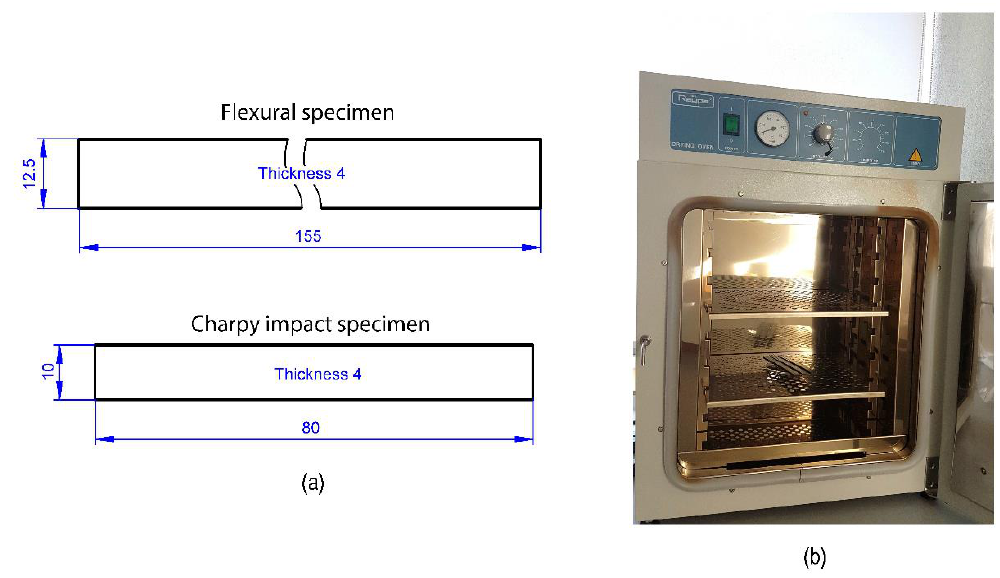
Figure 1. ( a ) Standard flexural and Charpy impact specimens according to ASTM D7264 and D6110 or ISO 179 recommendations. ( b ) Programmable oven used for the thermal ageing treatments. Table 2. Thermal ageing treatments for the carbon fibre-reinforced epoxy composites.